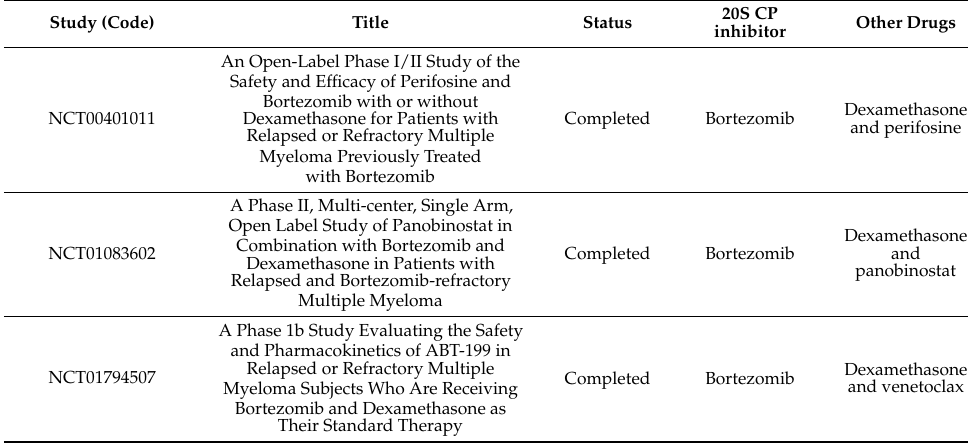
Table 4. Examples of clinical trials which apply combination therapies with 20S CP inhibitors. Adapted from: ClinicalTrials.gov (https://clinicaltrials.gov/ accessed on 22 February